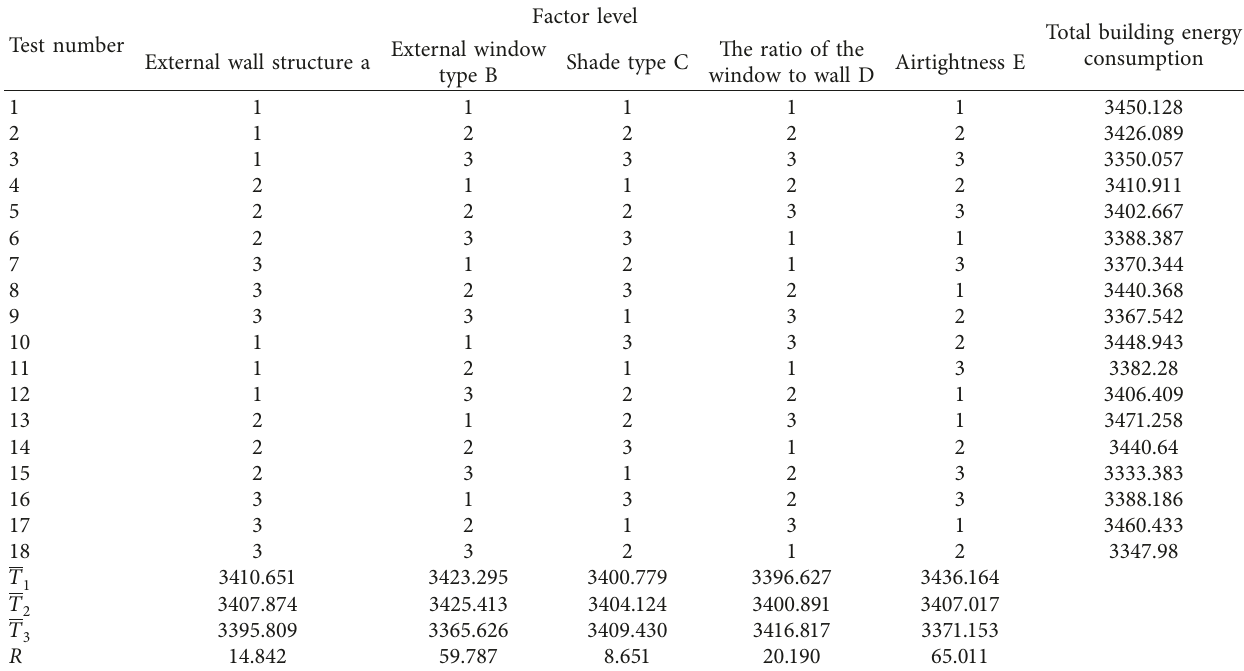
Table 8: Orthogonal experimental design and factor visual analysis of the public building envelope